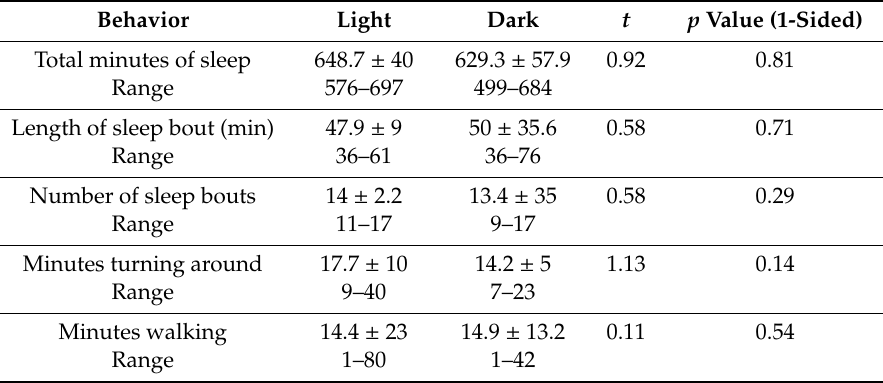
Table 2. Sleep times of shelter dogs in light and